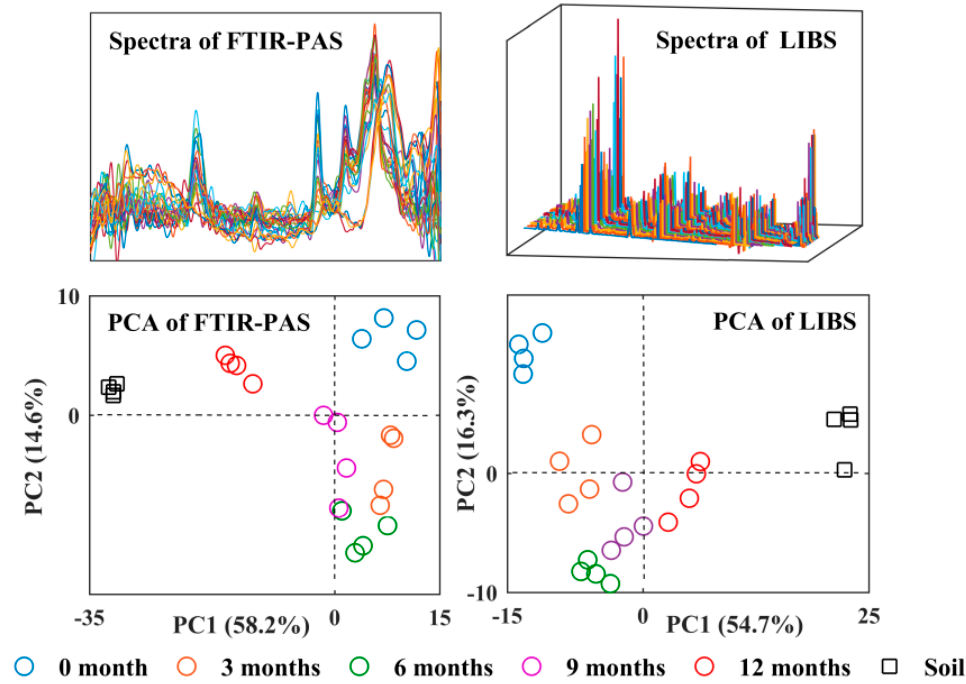
Figure 5. Spectra and PCA scatter plots of FTIR-PAS and LIBS for PA films and soil.